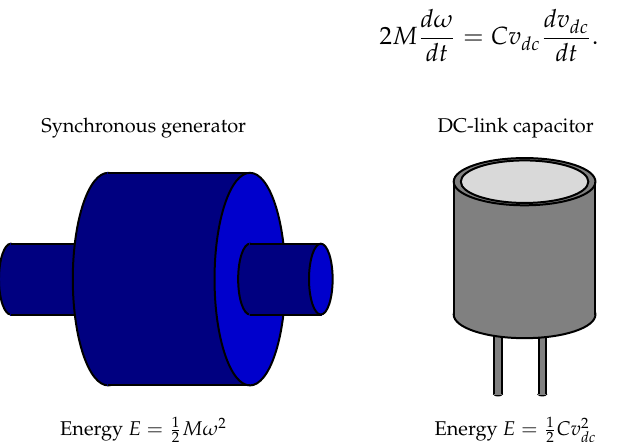
Figure 1. Analogy between the energies of the synchronous generator and the DC-link